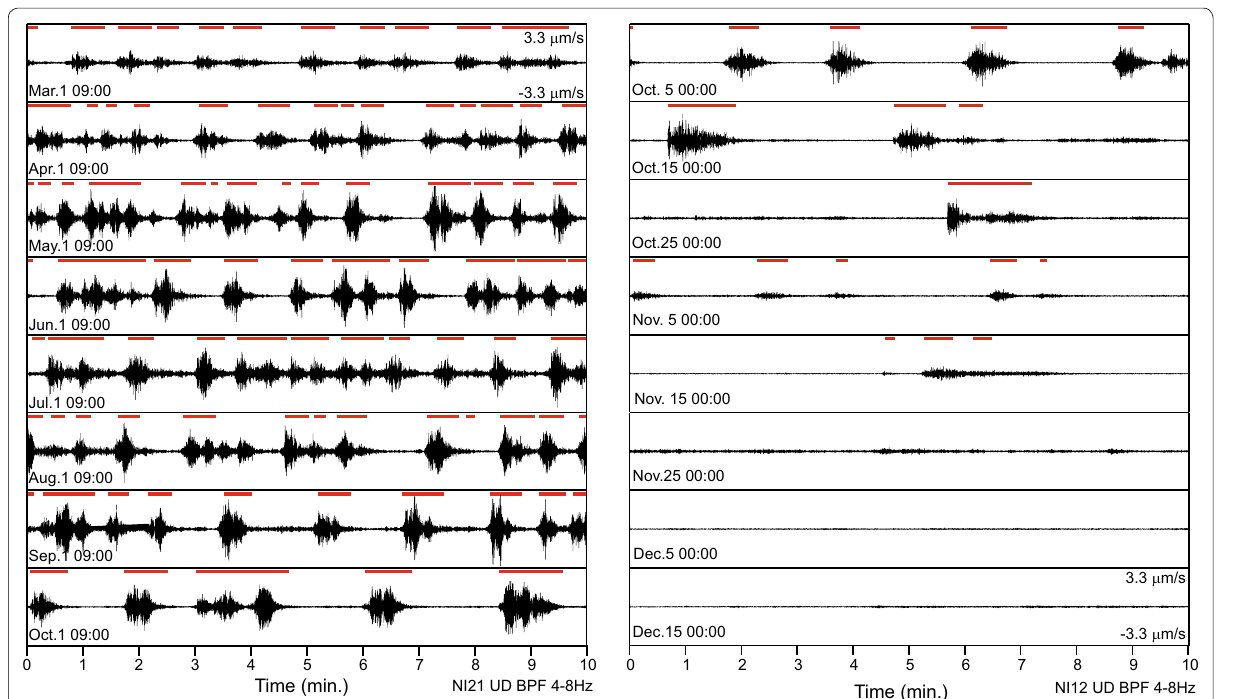
Fig. 4 Vertical component records of NI21 and NI12, and event detection using the STA/LTA method. All traces have the same amplitude scale. Left: seismic records with a duration of 10 min of vertical components for NI21. The records are band-passed from 4 to 8 Hz. Red lines indicate detec- tion of events using the STA/LTA method. In March and April 2015, smaller amplitudes were observed and the amplitude increased later. Intervals between events lengthened from beginning in August 2015. Right: seismic records with a duration of 10 min of vertical components for NI12. The records are band-passed from 4 to 8 Hz. Red lines indicate detection of events using the STA/LTA method. The number of events decreased and no events were detected from November 25,